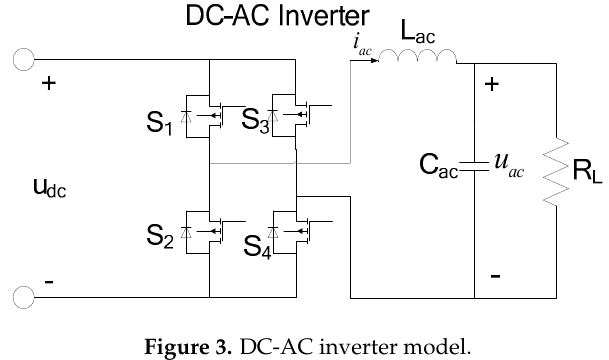
Figure 3. DC-AC inverter model.